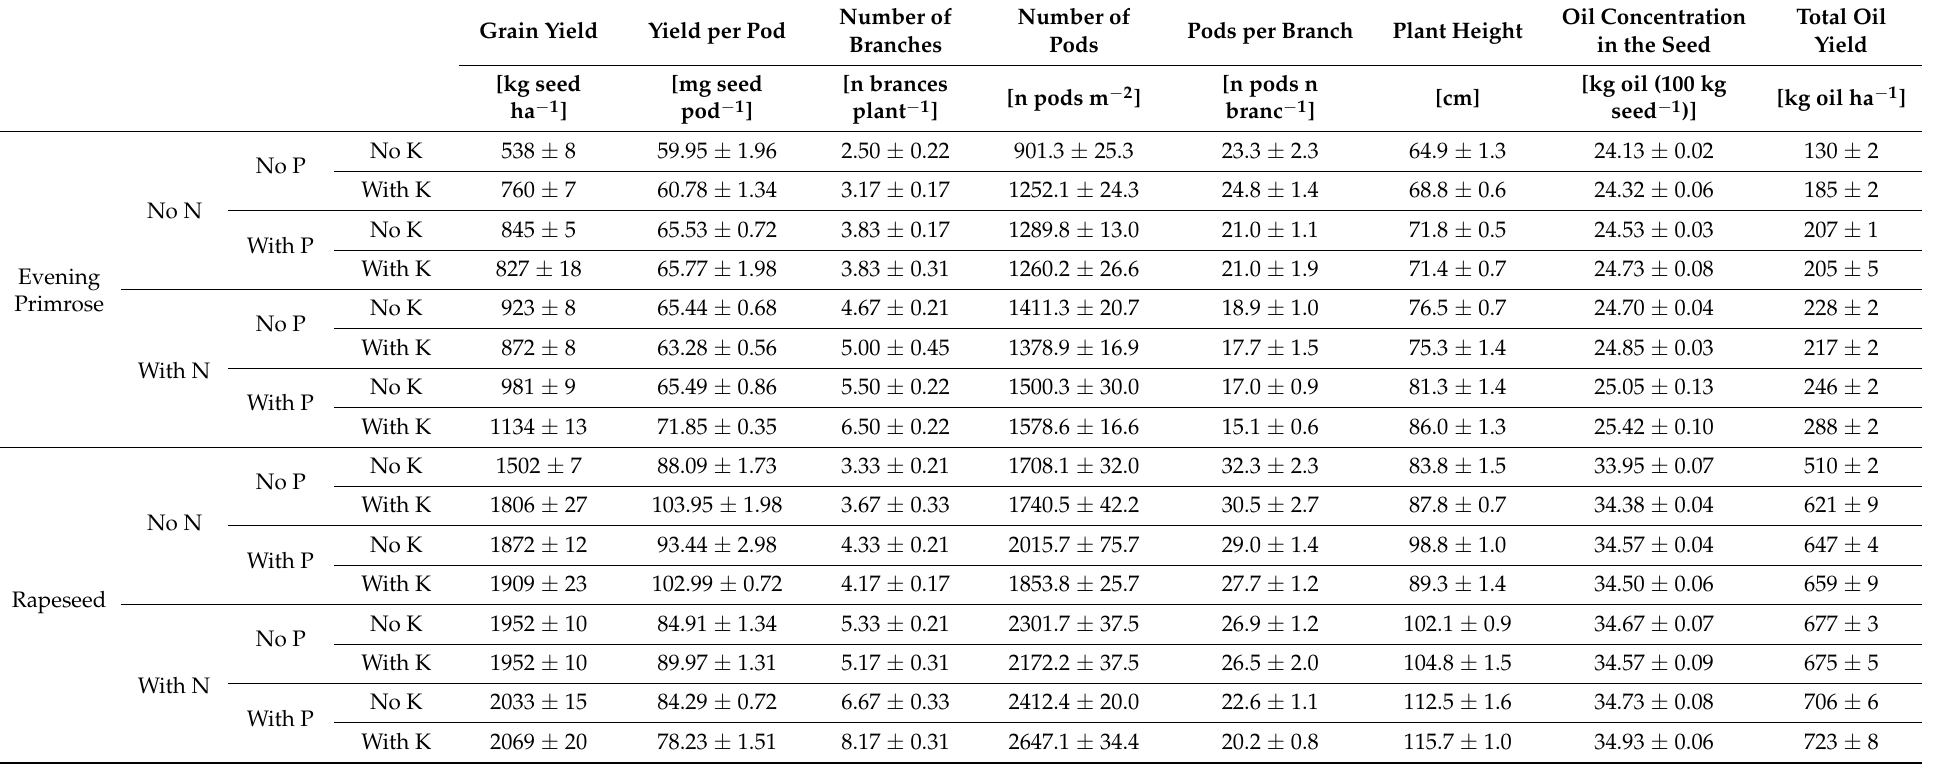
Table 2. Means ± standard error ( n = 6) of the yield, yield components, plant height, and oil concentration in the